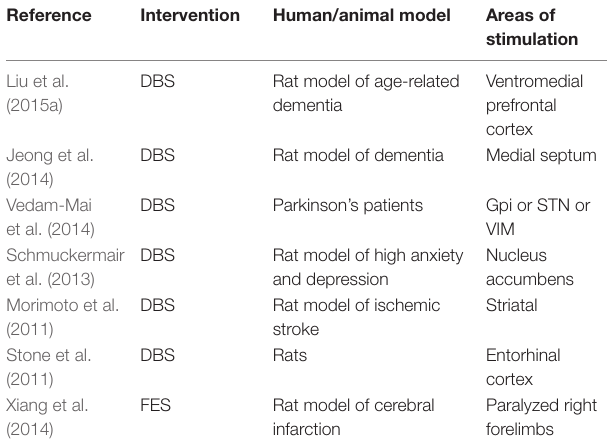
TABLe 1 | Overviews of recent DBS and FeS studies on NSC